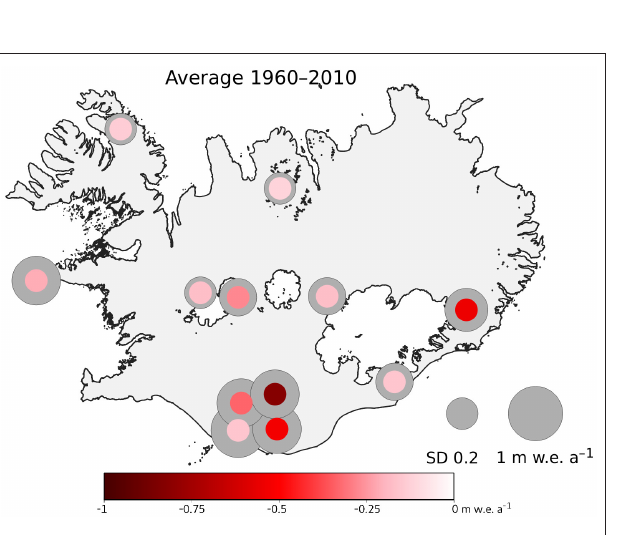
FIGURE 6 | Mass-balance average over the period 1960–2010. The size of the gray circles shows the temporal variability, estimated for each glacier as the standard deviation of the temporally homogenized mass balance, using a weight based on the length of each time